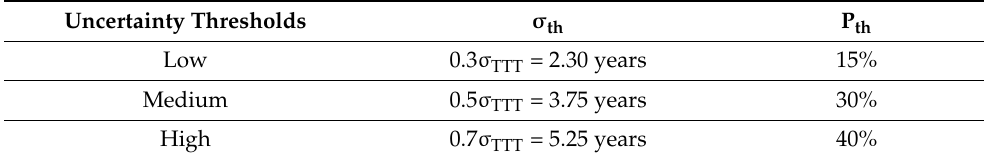
Table 6. Values of uncertainty thresholds to be embedded from Figure 2’s